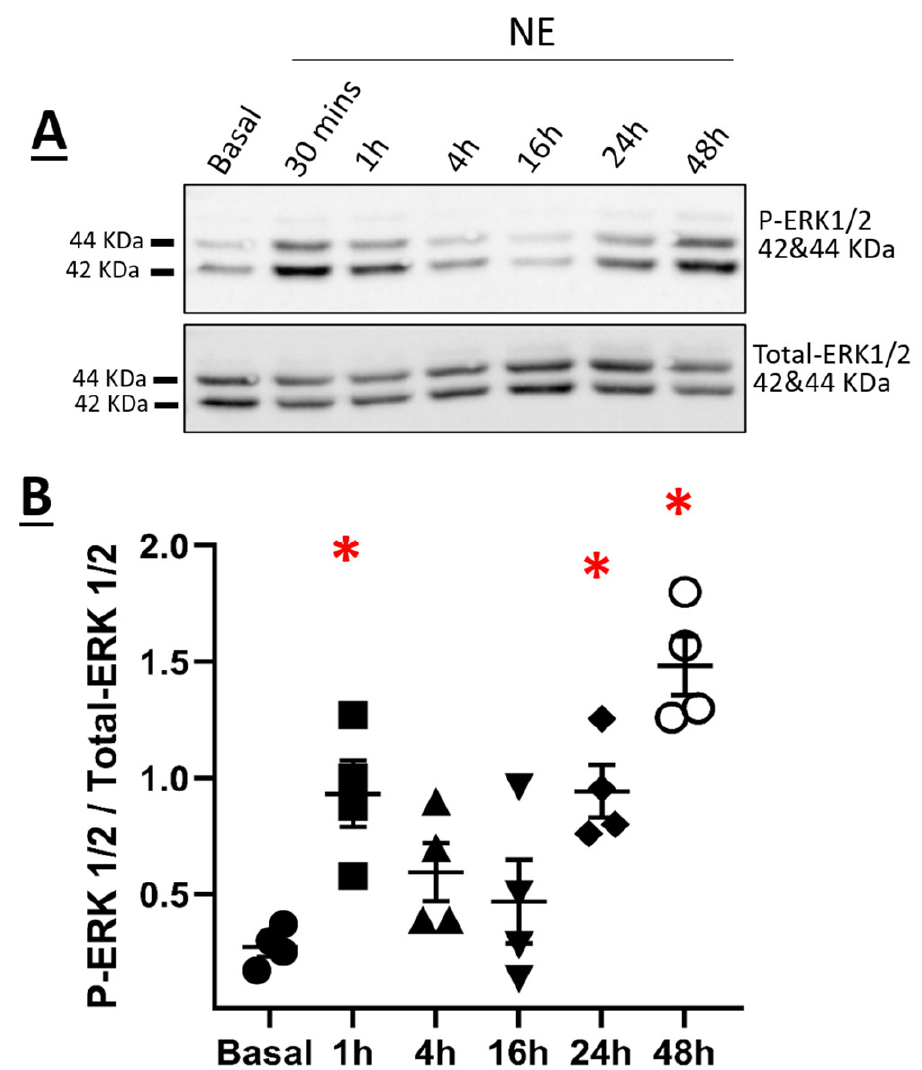
Figure 8. ( A ) Expression of p -ERK 1/2 in neonatal rat cardiomyocytes. Total proteins were extracted from neonatal rat ventricular cardiomyocytes. Proteins were separated on an 8% SDS-polyacrylamide gel, transferred to a nitrocellulose membrane, and probed with anti-P-ERK1/2 and anti-total-ERK antibodies overnight, and then incubated with HRP-conjugated goat anti-rabbit secondary antibody. Lanes were loaded with 30 µ g of proteins. NE: cardiomyocytes treated with 1 µ M norepinephrine. ( B ) Graph showing the total protein expression of P-ERK 1/2 normalized to total-ERK 1/2. * p < 0.01 vs. Basal; * p < 0.01 vs. Basal; (4 cardio-preparations). Statistical analysis was performed using one-way ANOVA.